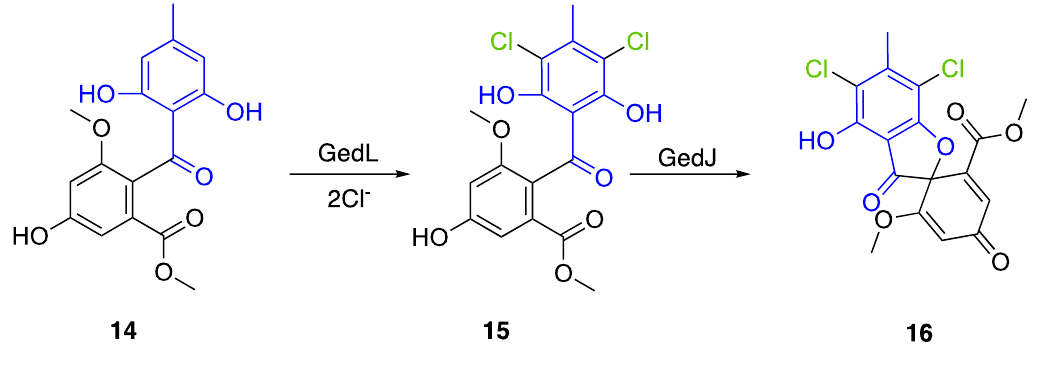
Figure 15. Dichlorination of sulochrin ( 14 ) by GedL in A. terreus to form dihydrogeodin ( 15 ) in the biosynthesis of geodin ( 16 ).